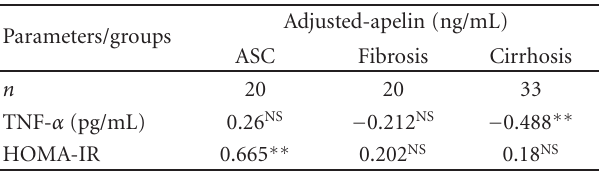
Table 5: Correlation coe ffi cients ( r ) of di ff erent parameters in pa- tients with CHC ( n =